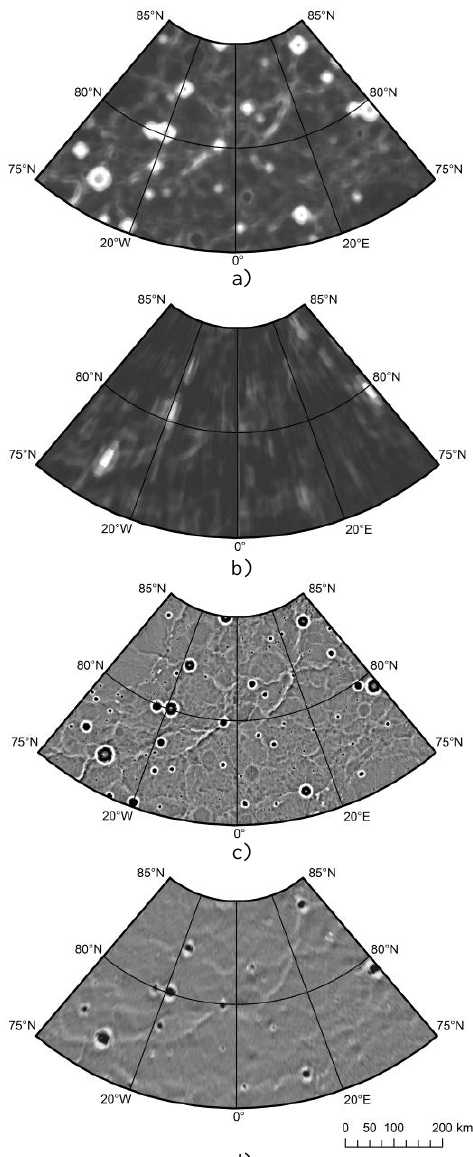
Figure 2. Demonstration of the potential of using MLA data near the North Pole of Mercury: a) IQR calculated by DEM with a resolution of 250 m/pixel (MLA); b) IQR calculated by global DEM with a resolution of 665 m/pixel (MDIS WAC and NAC); RTP calculated by DEM with a resolution of 250 m/pixel (MLA); d) RTP calculated by global DEM with a resolution of 665 m/pixel (MDIS WAC and